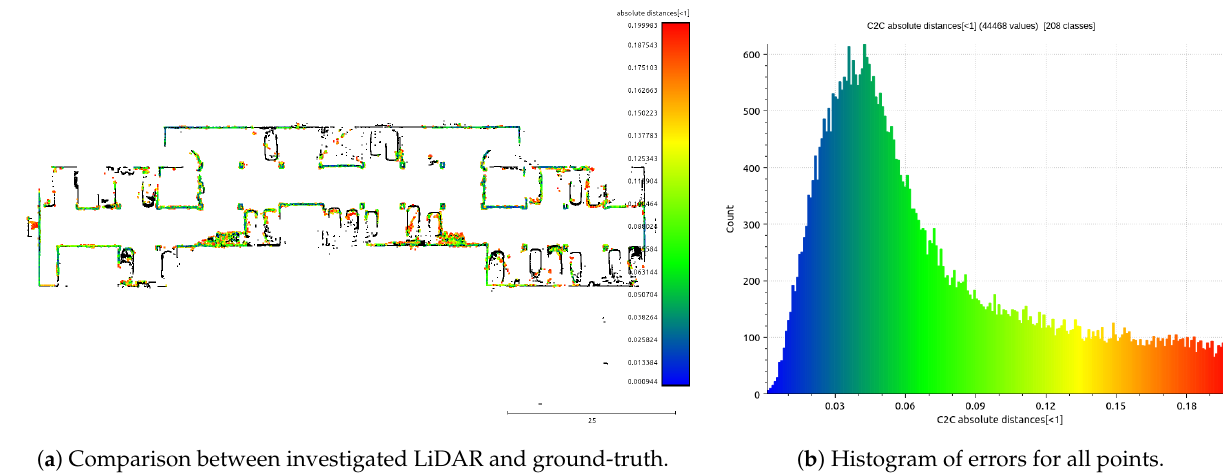
Figure 10. Result of the calibration algorithm for multiple measurement stations with histogram of